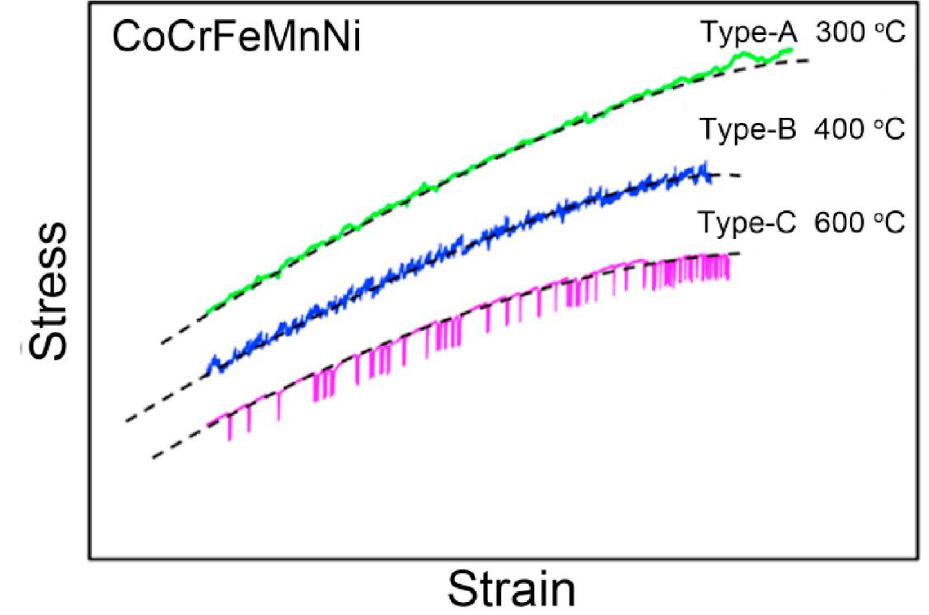
Figure 35. Stress vs. strain curves for the CoCrFeMnNi HEA tension tested at a strain rate of 1 × 10 − 4 s − 1 and temperatures of 300–600 °C (reproduced from Reference [181]). Table 5. Summary of the serration type exhibited by the CoCrFeMnNi HEA during tension at strain rates from 1 × 10 −4 to 1 × 10 −2 s −1 and temperatures of 300–600 °C (from Reference [153]). Strain Rate (s −1 ) Temperature (°C) Serration Type